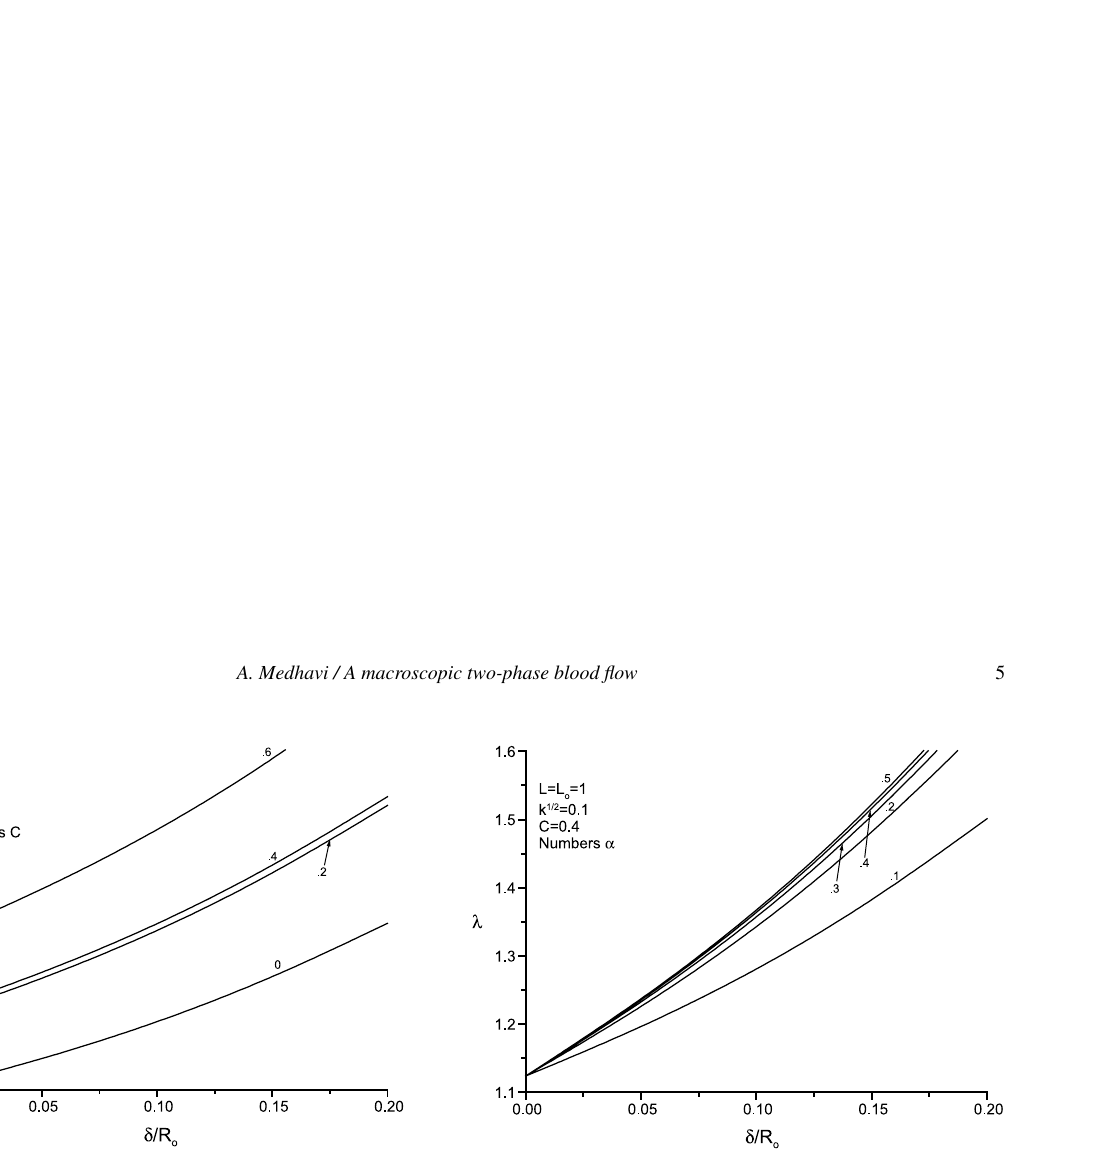
Fig. 2. Impedance, λ versus stenosis height, δ/ R o for different C.